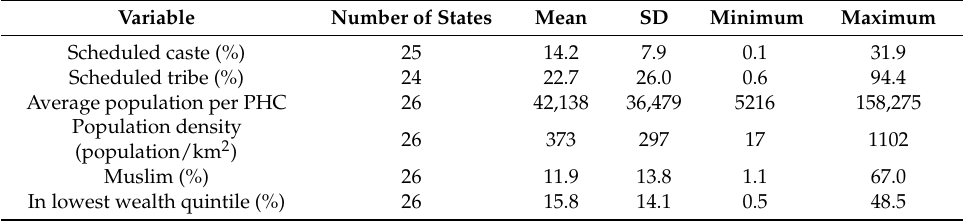
Table 2. Indian state-level characteristics from DLHS3 and the 2011 Census.